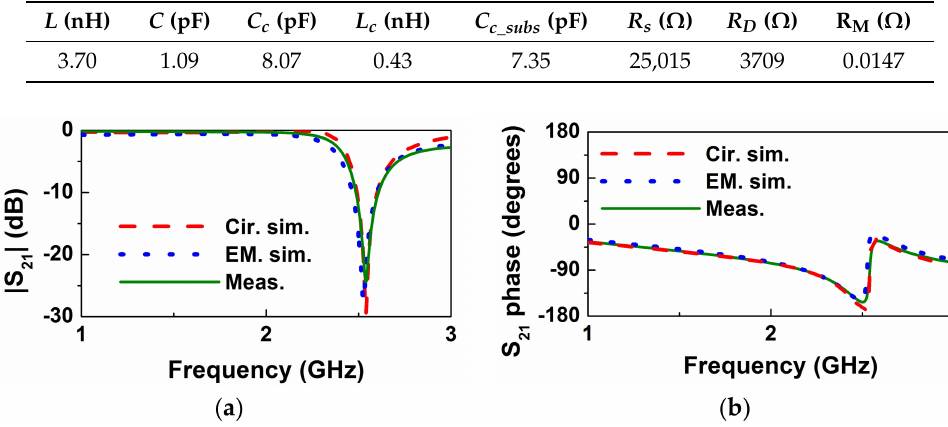
Figure 4. Transmission coefficient of the empty sensing structure of Figure 1. ( a ) Magnitude; ( b ) phase. Phase has been obtained after a reference plane